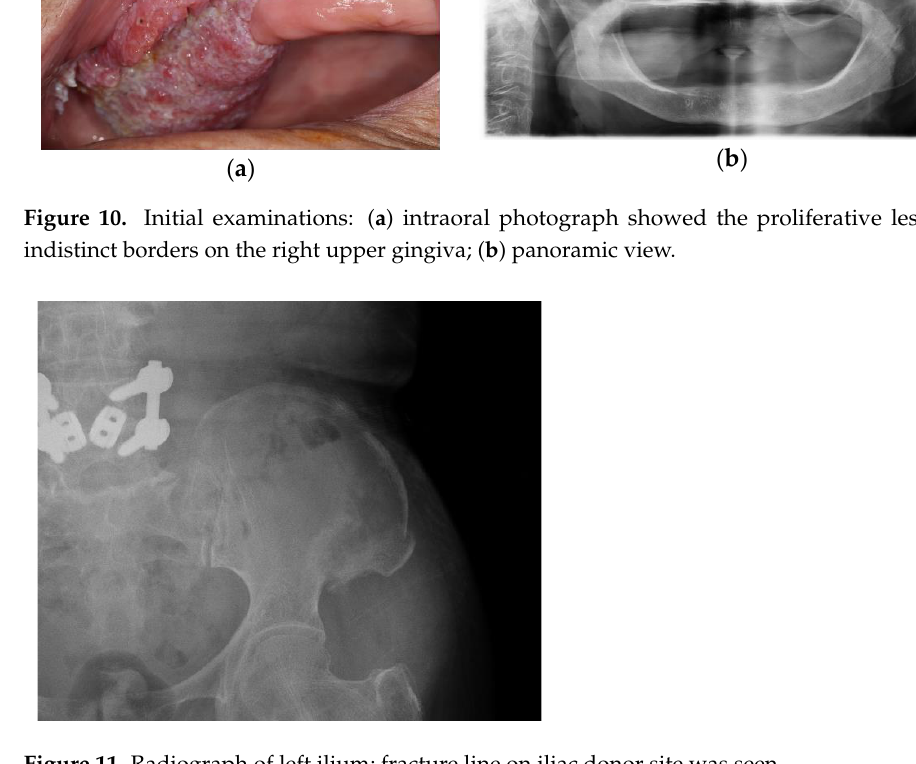
Figure 11. Radiograph of left ilium; fracture line on iliac donor site was